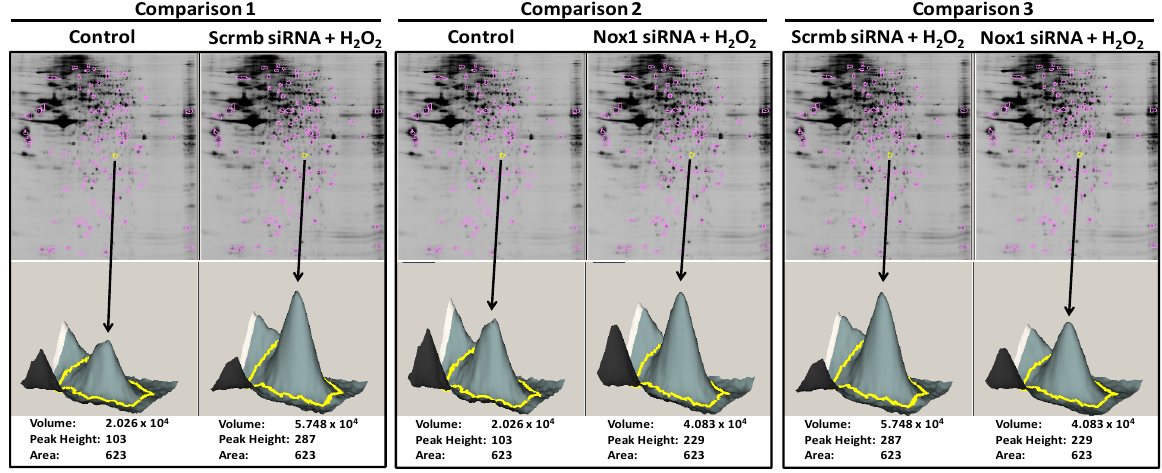
O treatment in a 2 2